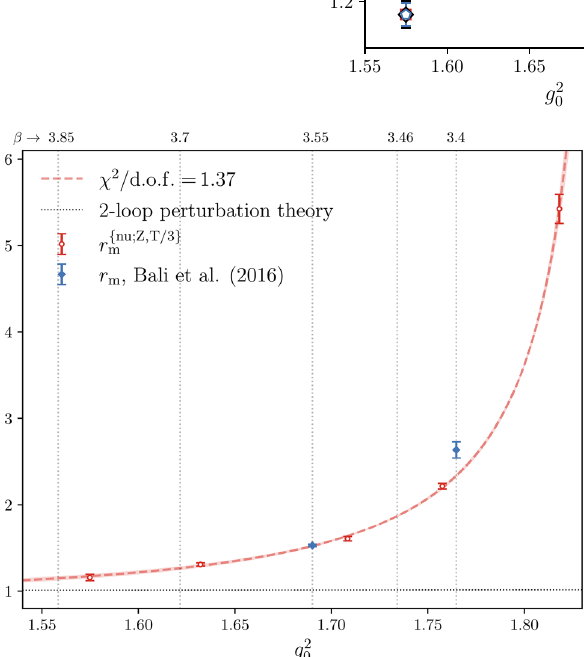
[18] for small couplings, of the